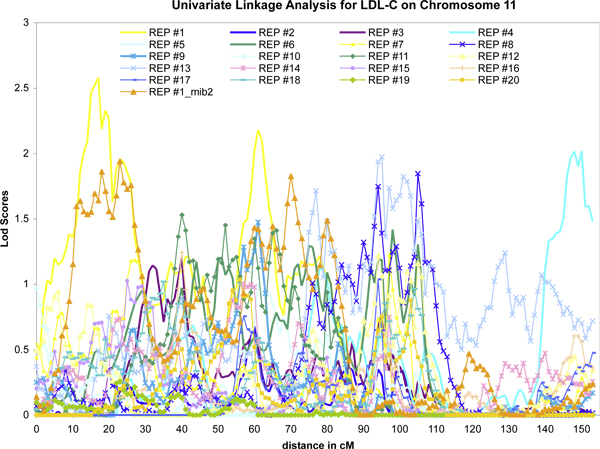
Different signals in different replicates. LDL SOLAR linkage results. While several regions exhibited LOD > 1 in multiple replicates, no region did so in all replicates.